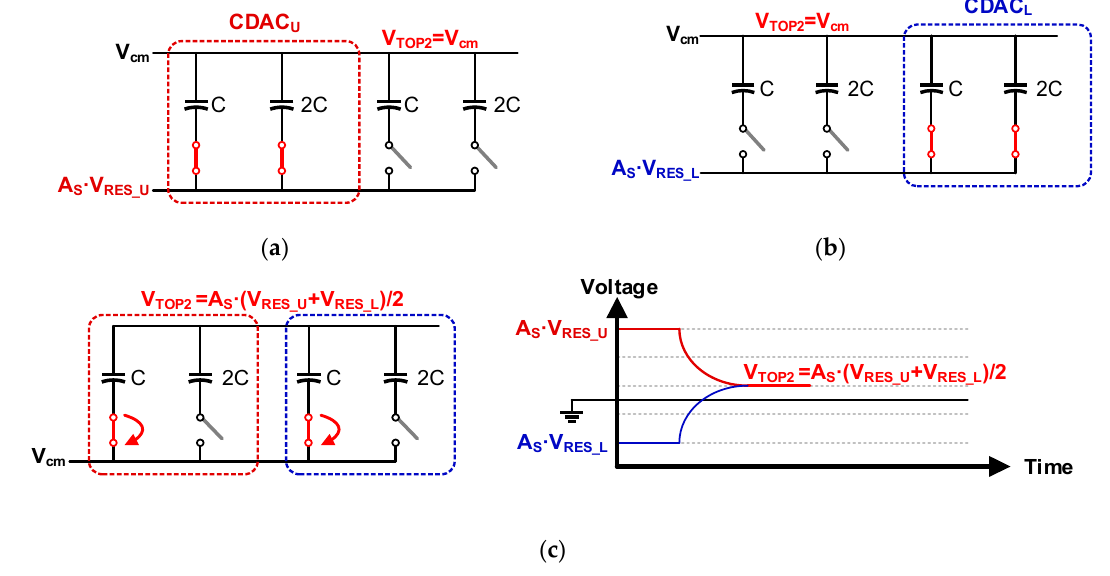
Figure 9. Schematic of the proposed interpolation SAR ADC.